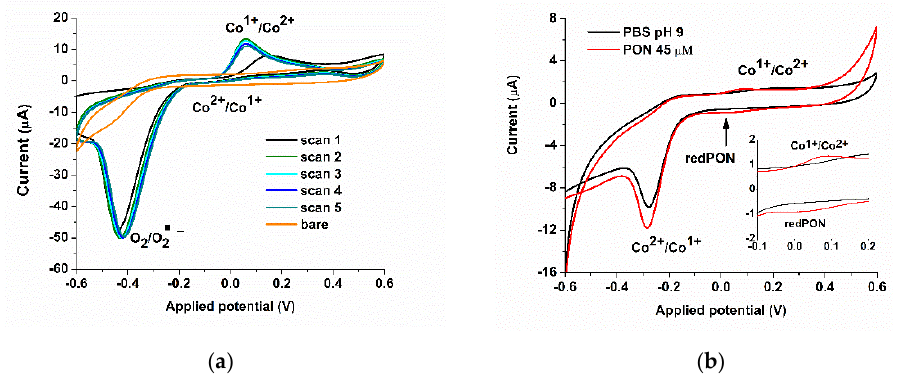
Figure 3. Cyclic Voltammetry (CV) of ( a ) the screen-printed carbon electrode (SPCE)/cobalt phthalocyanine (CoPc) electrode upon different scans, in PBS pH 12 [1]. The oxido-reduction processes are presented for the cobalt metallic center. ( b ) Cyclic voltammetry was registered using the SPCE/CoPc electrode in the absence (black) and in the presence (red) of 45 µ M PON (scan rate 9 mV/s), PBS pH 9. Zoom in of the redox peaks for PON from the same